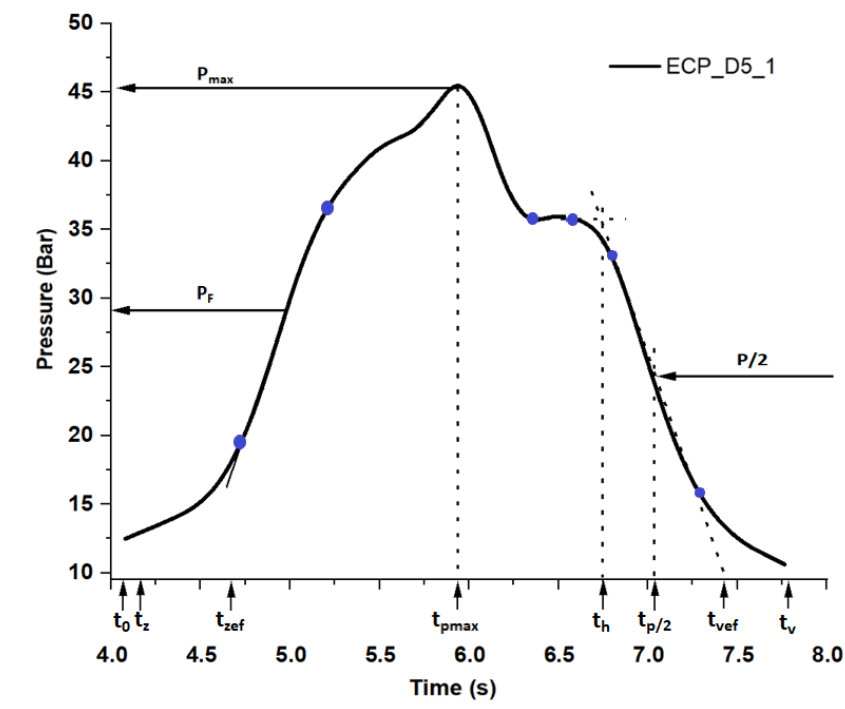
Figure 14. The burning rate profile and characteristics for the developed propellant.